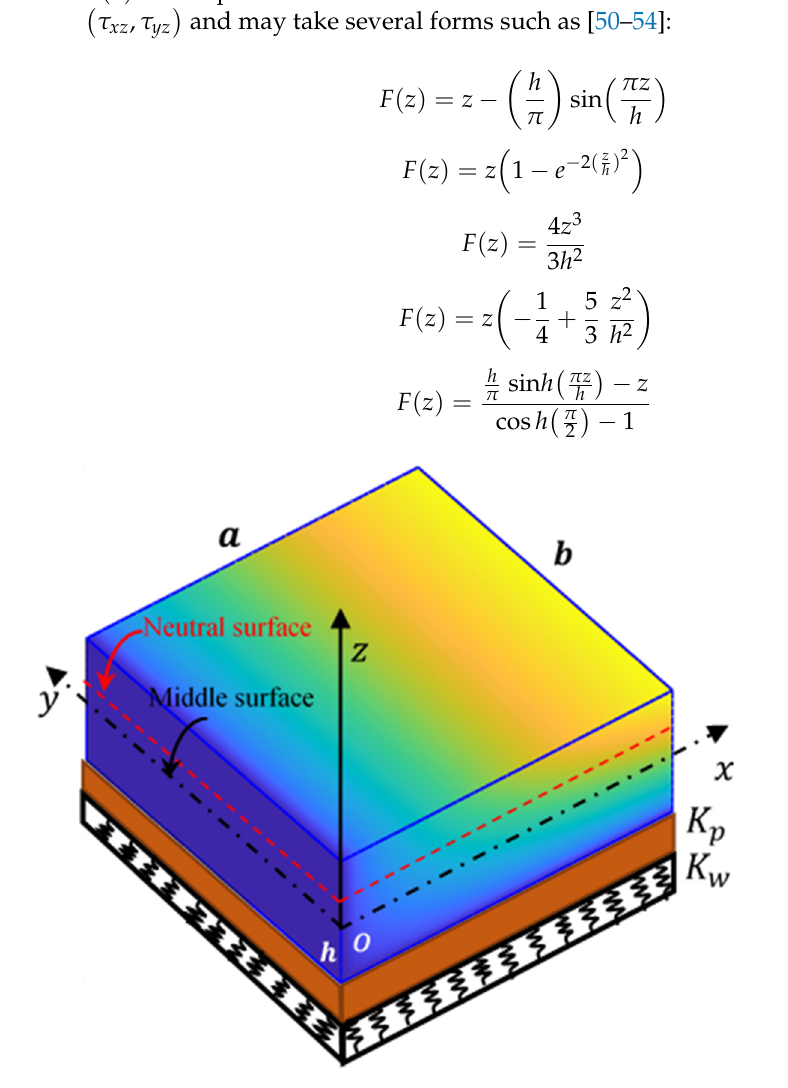
Figure 1. Schematic diagram of BDFG plate geometry with Winkler–Pasternak foundations. The normal and shear strains associated with the displacement field in Equation